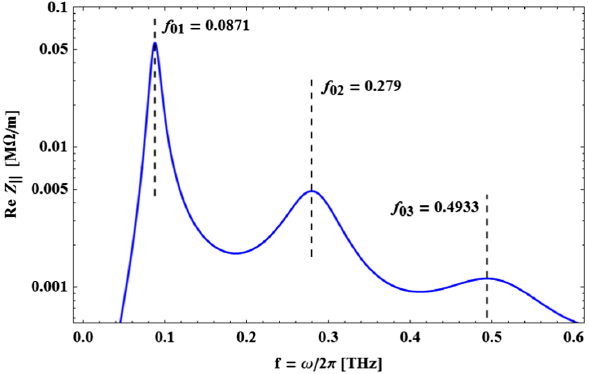
FIG. 3. The real part of longitudinal monopole impedance of a two-layer metal-dielectric waveguide for a 1 ¼ 2 mm, d ¼ 200 μ m, ε 0